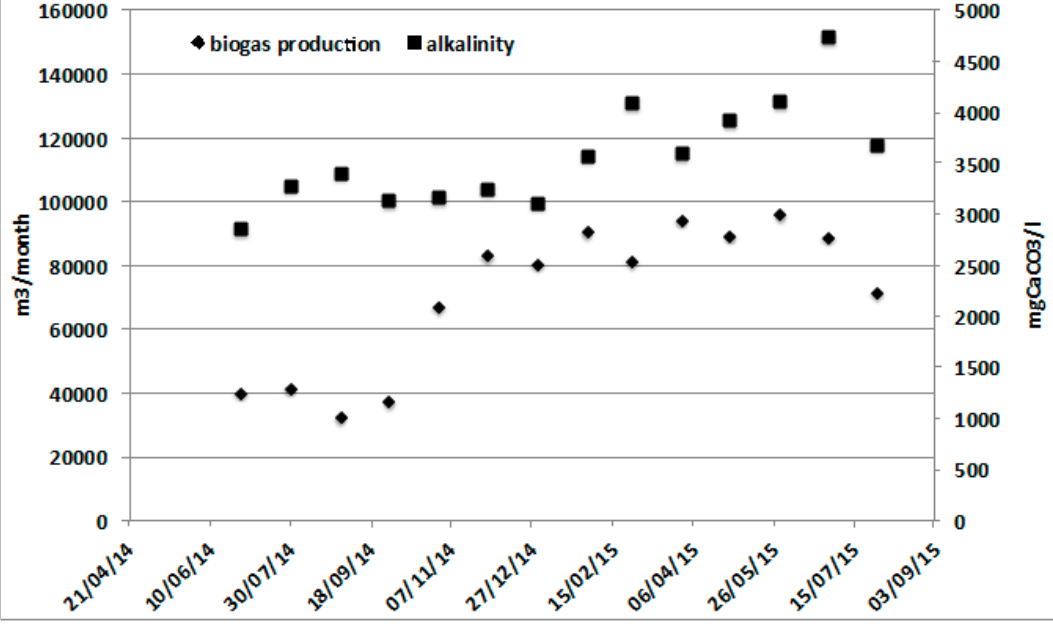
Figure 5. Rovereto AD biogas production changing from mono- to codigestion. The average values of the monitored period are given in Table